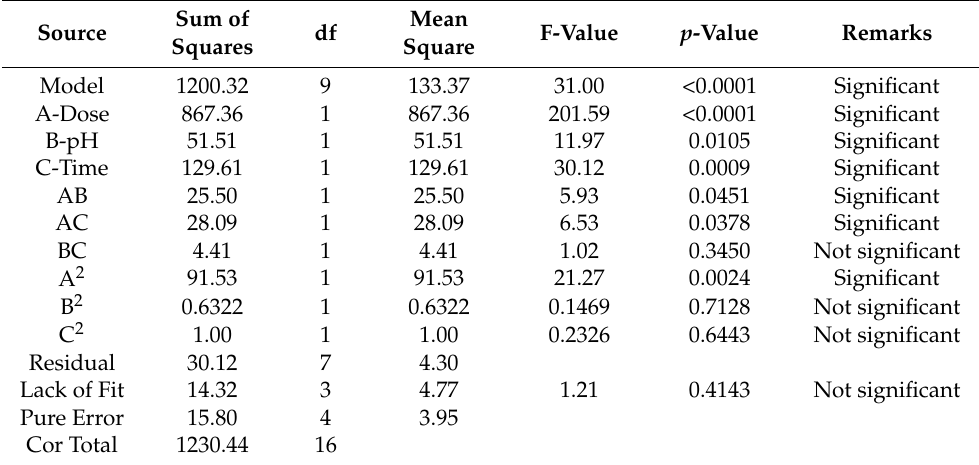
Table 4. Analysis of variance (ANOVA) for MB removal (%). Sum Source